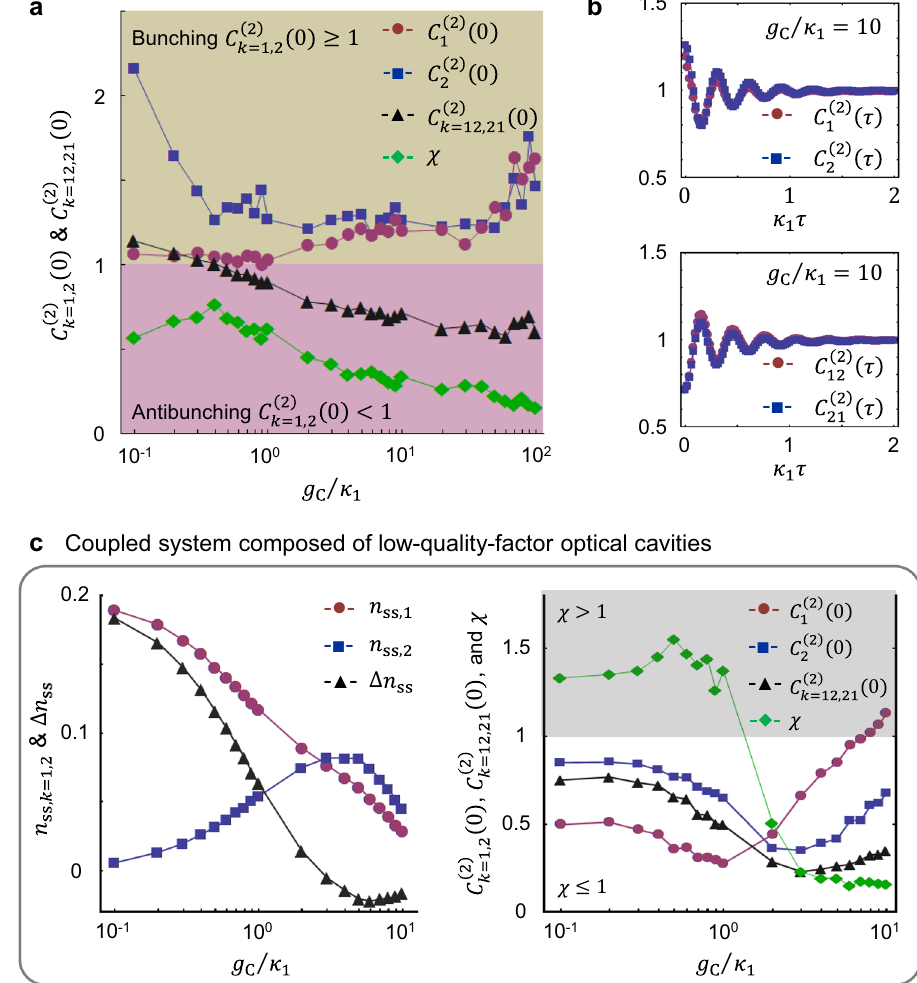
0 ð Þ and cross- k ¼ 1 ; 2